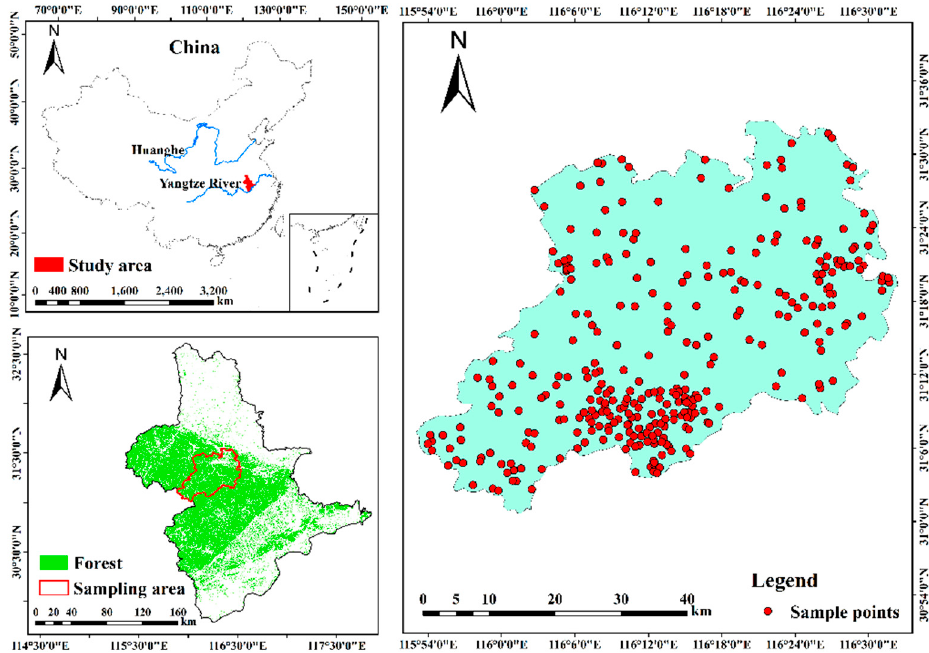
Figure 1. Location of the study area and the distribution of sampling points.